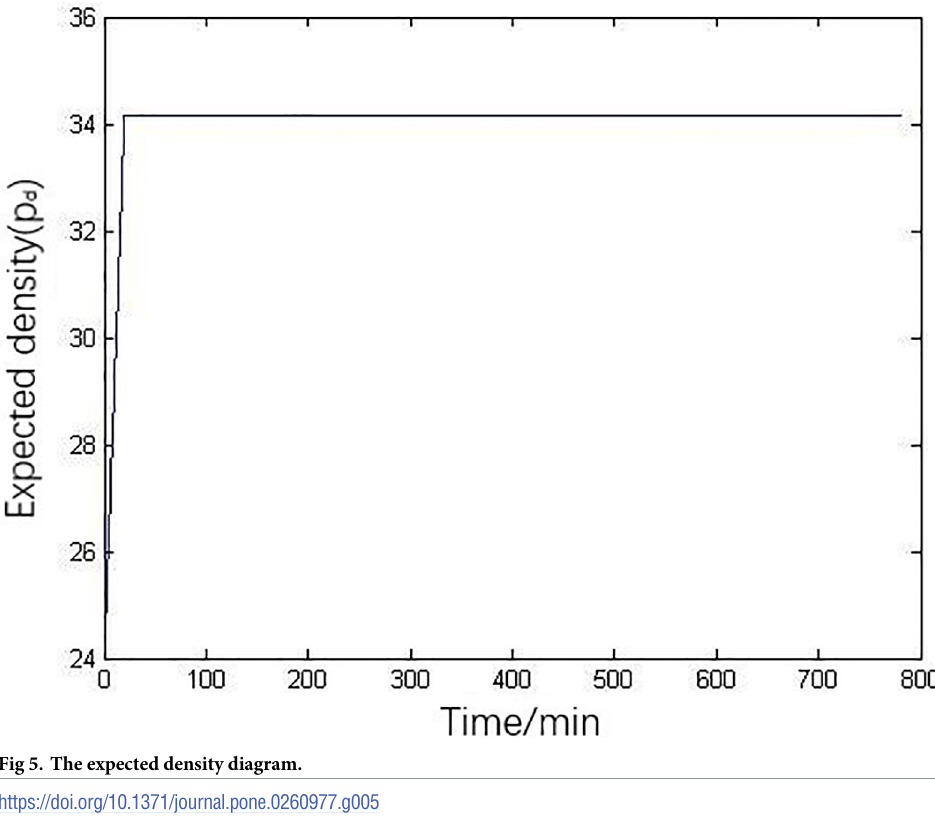
Fig 5. The expected density diagram.